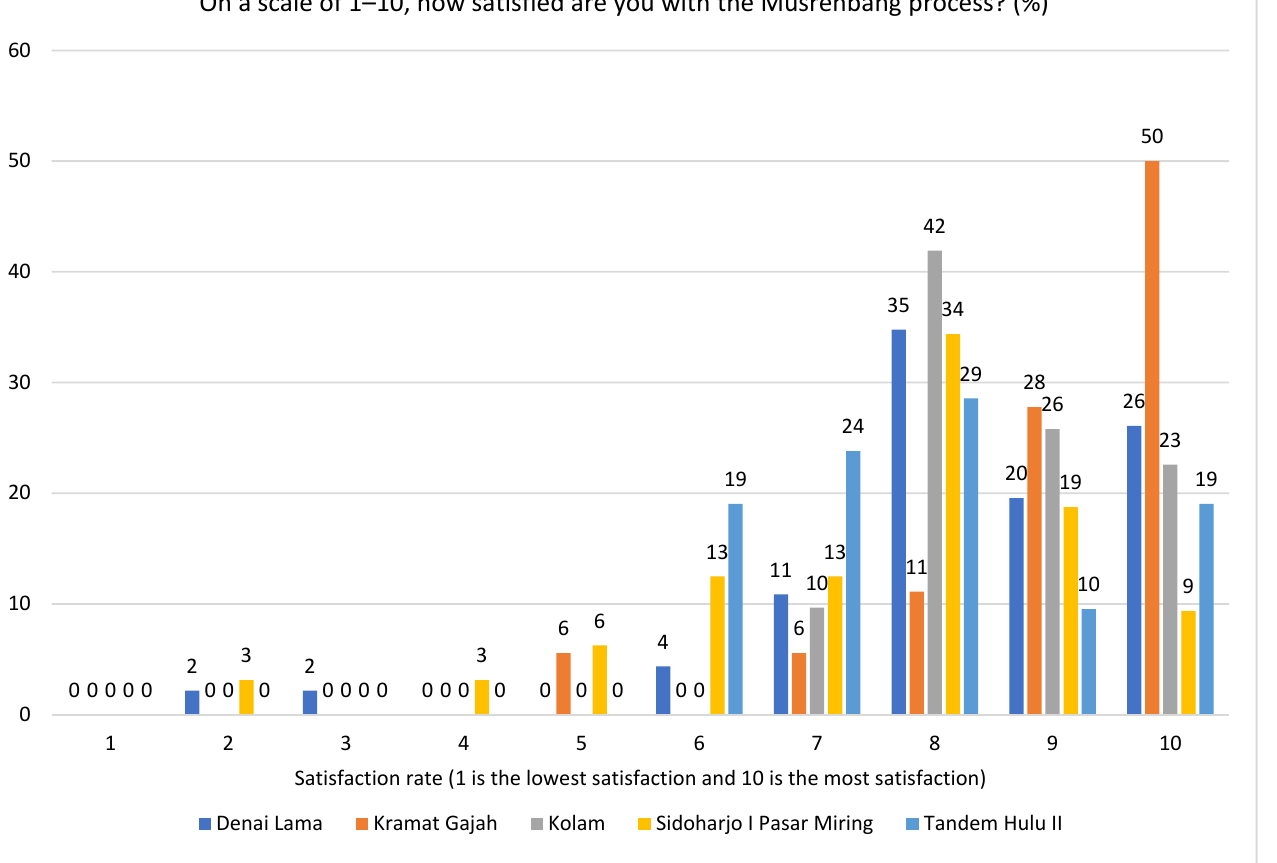
Figure 10. Participants’ satisfaction with the Musrenbang process.